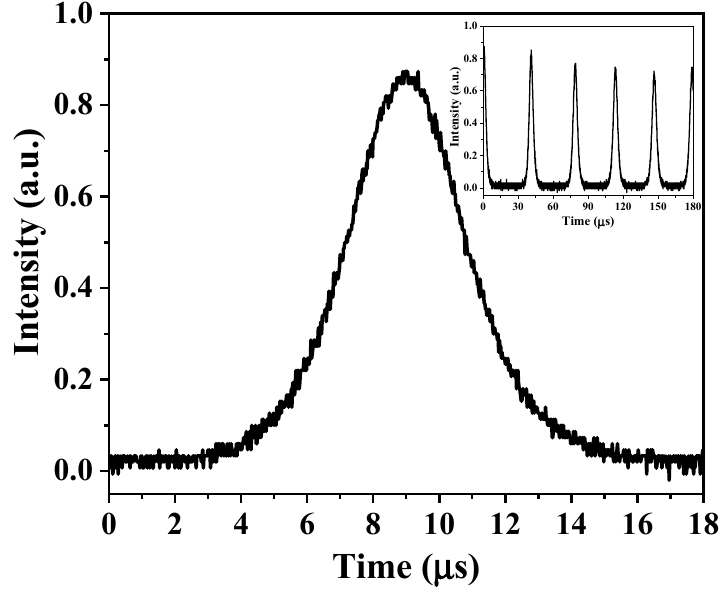
Figure 5. A pulse profile of the threshold pump power. (insert) A pulse sequence of the Q-switched laser. The beam quality factor, M 2 , in the Q-switching operation was studied at the average output power of 639 mW, taking advantage of the knife-edge method. Figure 6 shows the laser beam radii depending on their location relative to the focal lens, which was used for leading out the waist of the oscillating beam in the cavity. Through Gaussian fitting, the M 2 factors was calculated to be 1.25.